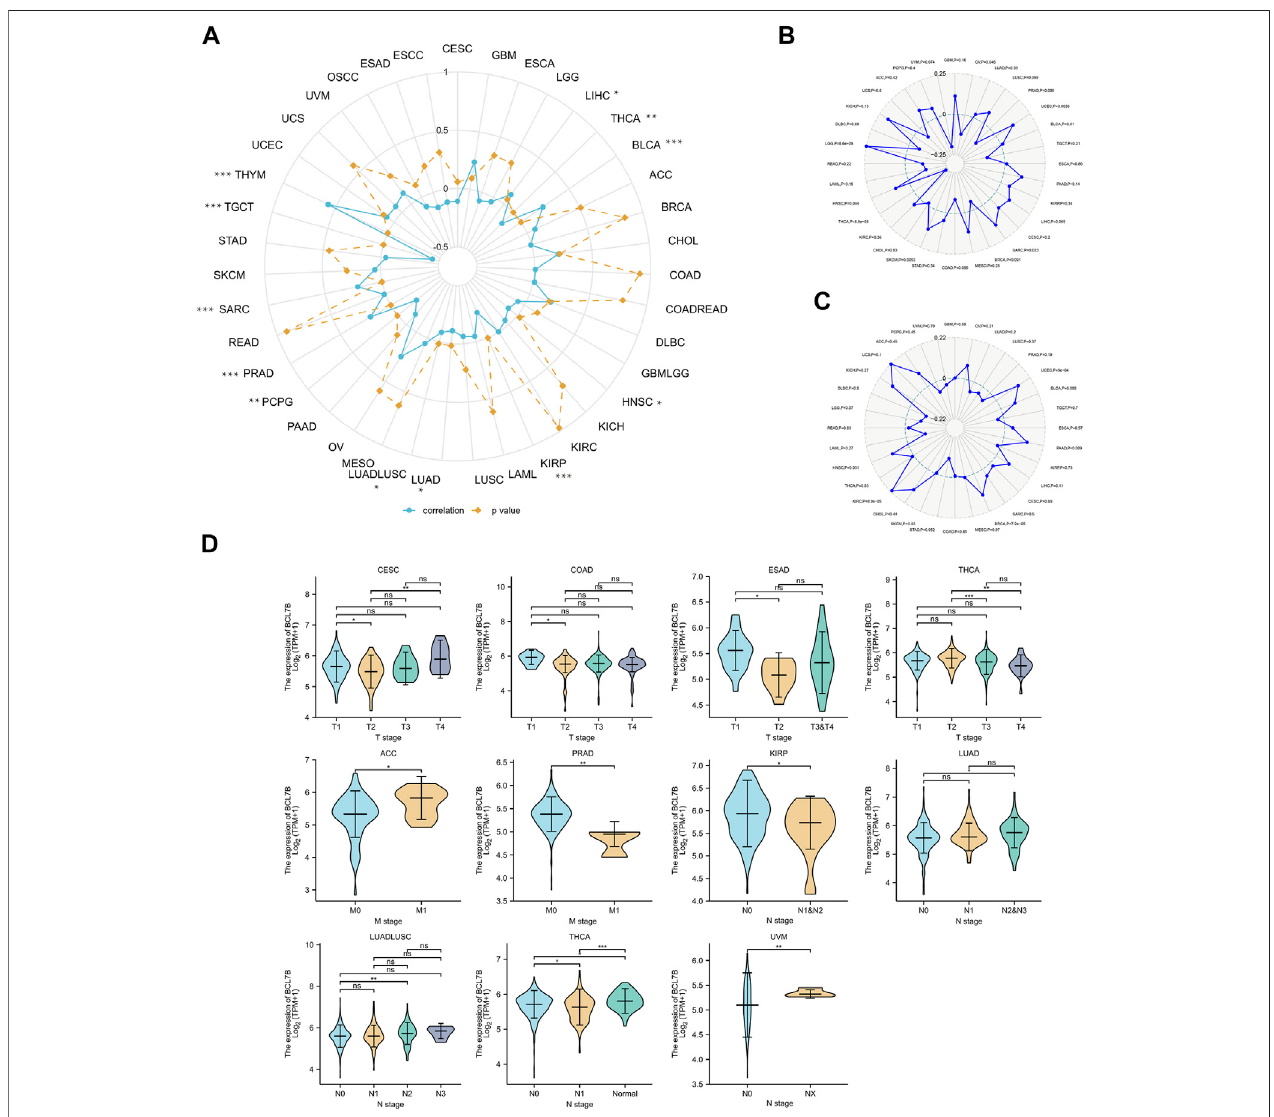
FIGURE 5 | Relationship between BCL7B gene expression and DNA methylation, and clinical TNM stage in pan-cancer. (A) BCL7B gene expression was notably positivelycorrelatedwithDNAmethylationinLIHC( p =0.049),BLCA( p < 0.001),PRAD( p < 0.001),SARC( p < 0.001),andTHYM( p < 0.001)andnegativelyinTHCA( p = 0.002), HNSC ( p = 0.027), KIRP ( p < 0.001), LUADLUSC ( p = 0.016), LUAD ( p = 0.017), PCPG ( p = 0.005), and TGCT ( p = 0.002). (B) sExpression of BCL7B gene was noticeably relevant to TMB in OV ( p = 0.046), PRAD ( p = 0.005), UCEC ( p = 0.0036), SARC ( p = 0.023), SKCM ( p = 0.0052), THCA ( p < 0.001), HNSC ( p = 0.044), and LGG ( p < 0.001). (C) Expression of BCL7B in UCEC ( p < 0.001), BRCA ( p < 0.001), KIRC ( p < 0.001), and HNSC ( p = 0.031) was notably correlated with MSI. (D) BCL7B gene expression was different in cancer patients with distinguishing clinical T(CESC, COAD, ESAD, and THCA), M (ACC and PRAD), and N (KIRP, LUADLUSC, THCA, and UVM) stages. p p < 0.05, pp p < 0.01, and ppp p < 0.001.